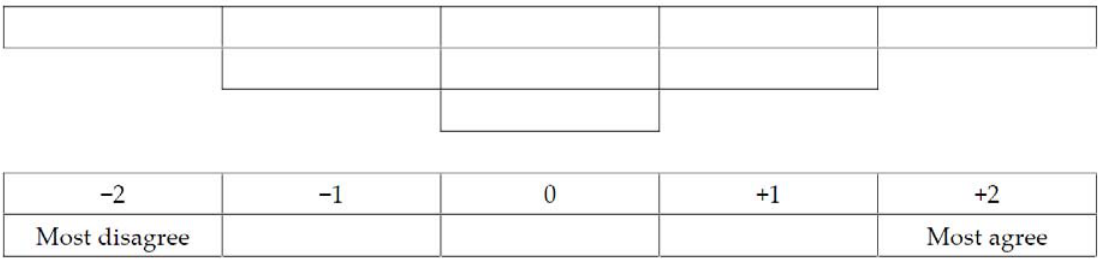
Figure 1. Shape of the used Q ‐ grid.